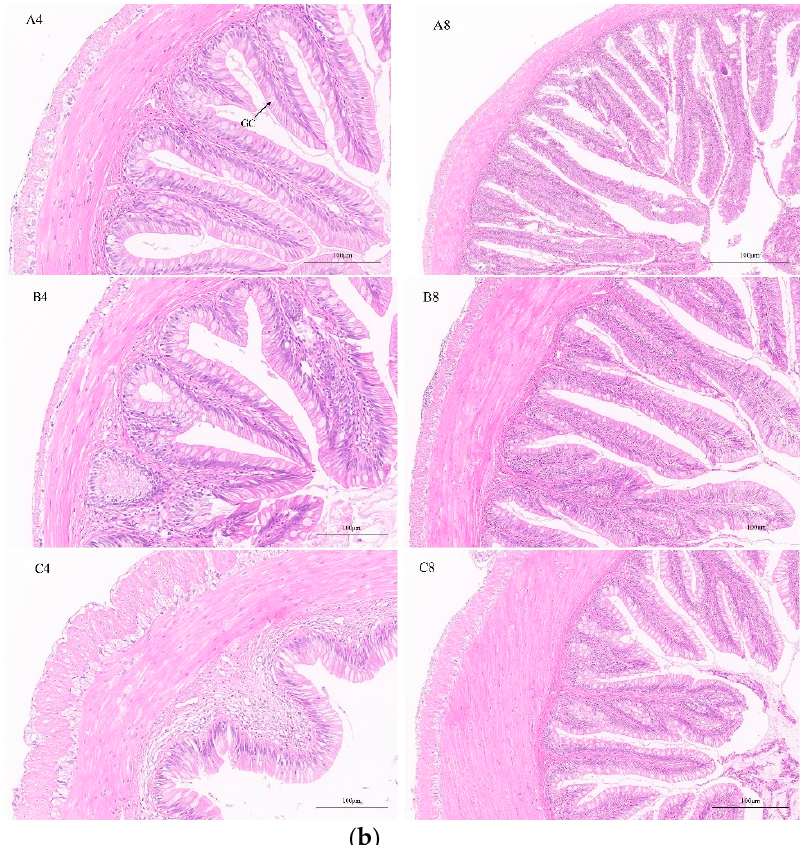
Figure 1. ( a ) HE-stained sections of intestinal tissues of juvenile largemouth bass from the fast-growing (FG) and slow-growing (SG) groups (100×). ( b ) HE-stained sections of intestinal tissues of juvenile largemouth bass from the fast-growing (FG) and slow-growing (SG) groups (400×). Note: A1 represents the foregut of the slow-growing group (100×); A2 represents the foregut of the fast-growing group (100×); B1 represents the midgut of the slow-growing group (100×); B2 represents the midgut of the fast-growing group. C1 represents the hindgut of the slow-growing group (100×); C2 represents the hindgut of the fast-growing group (100×); A4 represents the foregut of the slow-growing group (400×); A8 represents the foregut of the fast-growing group (400×); B4 represents the midgut of the fast-growing group (400×); B8 represents the midgut of the fast-growing group (400×); C4 represents the hindgut of the slow-growing group (100×); C8 represents the hindgut of the fast-growing group (100×); FL: Fold length; FW: Fold width; CD: Crypt depth; GC: Goblet cell; MT: Muscle thickness.